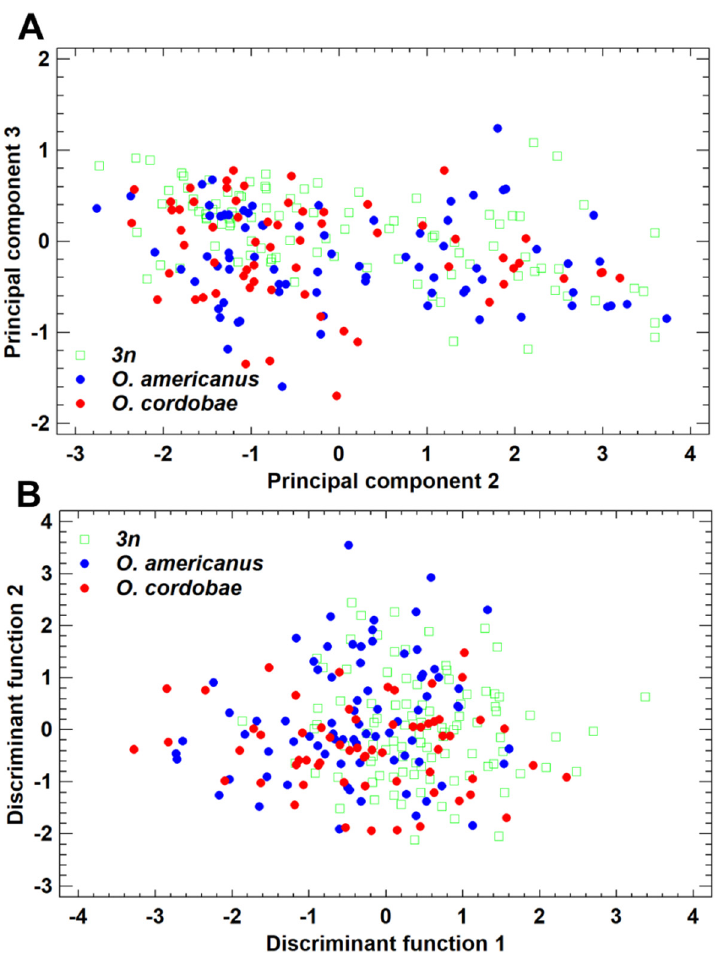
Figure 2. Morphometric differentiation of di-, tri-, and tetraploid Odontophrynus taxa at the La Escon- dida contact zone. ( A ) Scatter plot of PC scores without a priori delimitation of groups. ( B ) Scatter plot of discriminant function scores with a priori delimitation of groups.